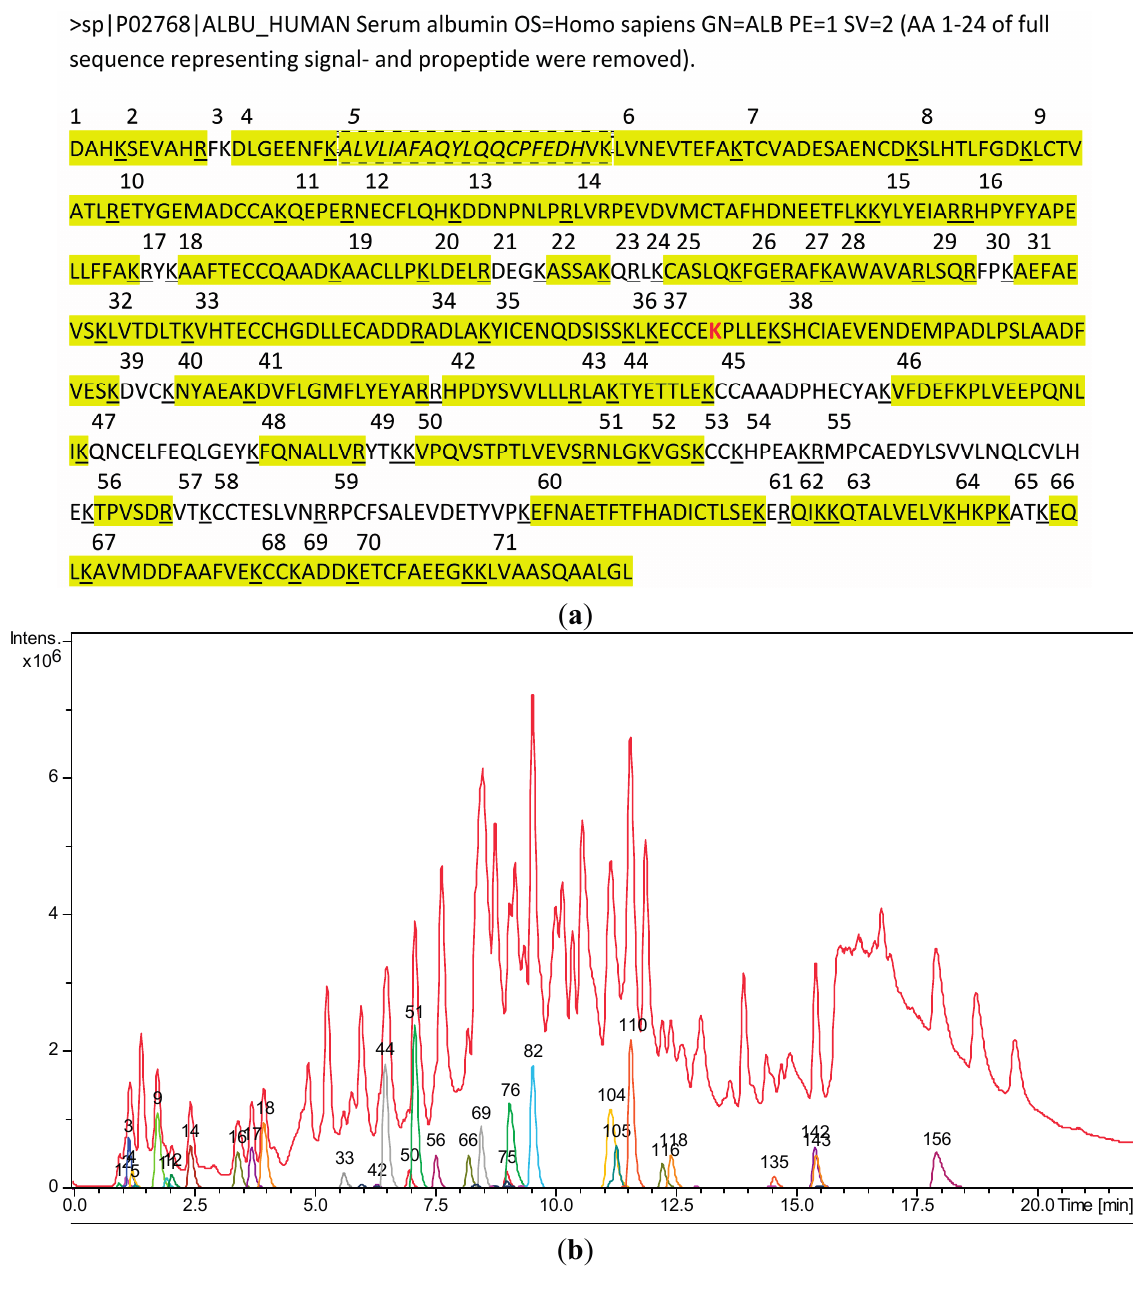
Figure 2. ( a ) Amino acid sequence of human serum albumin (HSA) with tryptic cleavage sites (underlined). The fragment T21-41 containing the only free cysteine residue (C34) is marked with a dashed line. Amino acids that are part of the tryptic peptides detected under our analytical conditions are marked in yellow. For fragment sequences and mass data, see Table 1. ( b ) LCMS analysis of the tryptic digest mixture obtained from untreated HSA. fragments that could be assigned particular parts of the HSA sequence. For numbering, see Table 1; the fragment labeled 156 represents the (T21-41) 2 SS